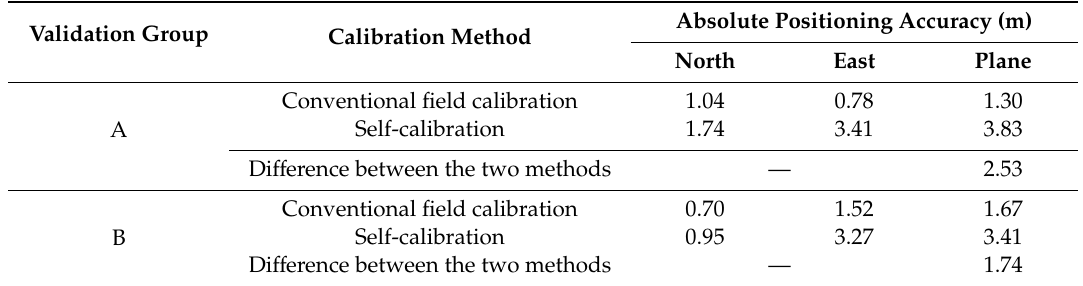
Table 8. Comparison between conventional field calibration and proposed self-calibration